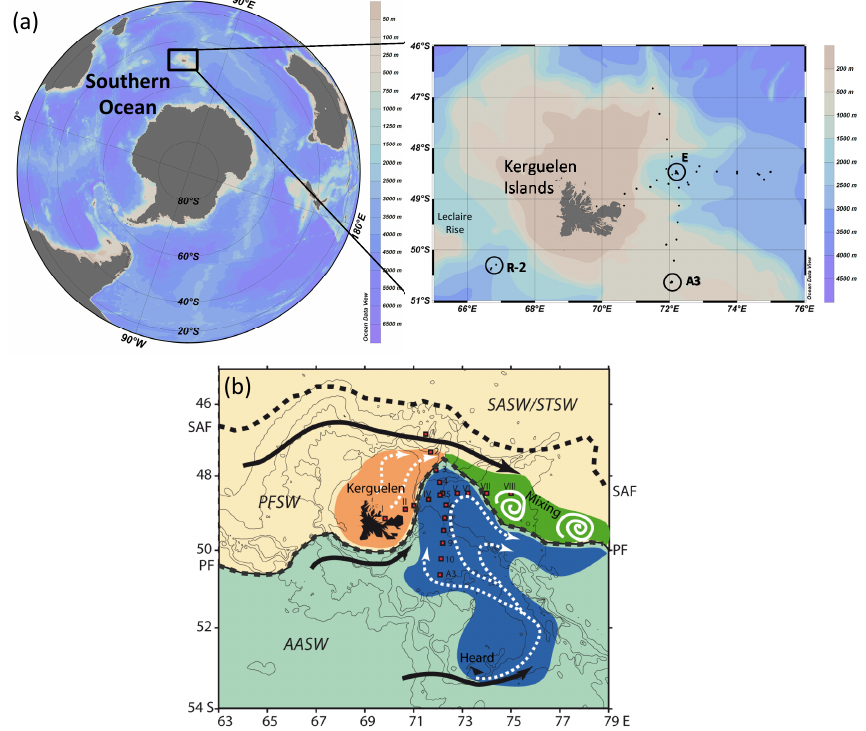
Figure 1. (a) The location of KEOPS-2 in the Indian sector of the Southern Ocean, showing bathymetry around the Kerguelen Archipelago. Our biogeochemical iron budgets focus on three process stations (open black circles): reference R-2 (50 ◦ 2 (cid:48) S, 66 ◦ 4 (cid:48) E), plateau A3 (50 ◦ 4 (cid:48) S, 72 ◦ 0 (cid:48) E) and plume E (48 ◦ 3 (cid:48) S, 72 ◦ 1 (cid:48) E). Black dots mark the positions of the other stations visited, including N–S and E–W survey transects at the start of the KEOPS-2 expedition. (b) A schematic of the mean regional circulation of surface and subsurface waters around the Kerguelen Archipelago, indicating circumpolar Southern Ocean fronts, locations of stations along N–S and E–W transects, and pathways and origins of different water masses flowing on the plateau and offshore into the plume. The abbreviations are Antarctic Surface Water (AASW), Polar Front Surface Water (PFSW), Subantarctic Surface Water (SASW), Subtropical Surface Water (STSW), Subantarctic Front (SAF) and the polar front (PF) (reproduced with permission from Park et al. (2014a), courtesy of Isabelle Durand and Young-Hyang Park, LOCEAN/DMPA, MNHN, Paris).